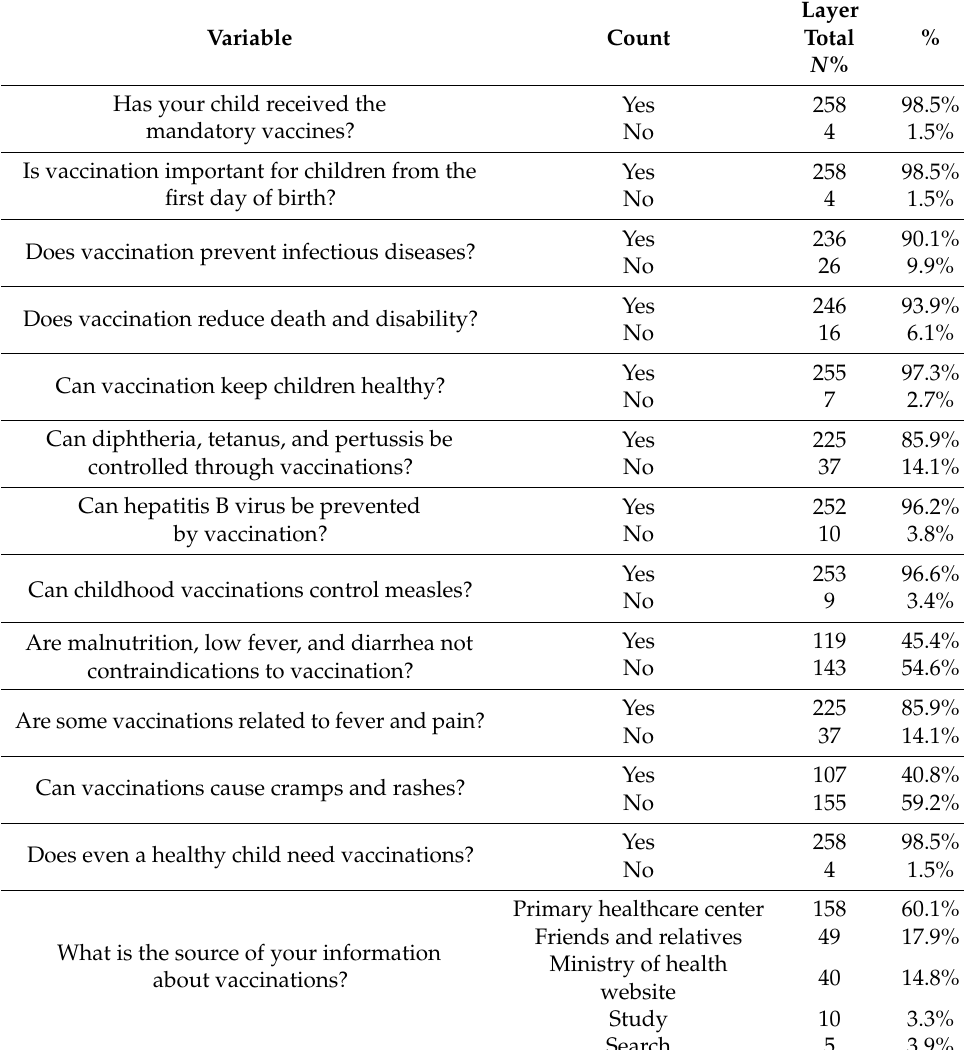
N = 262. This table uses descriptive statistics: frequency ( n ) and percentage